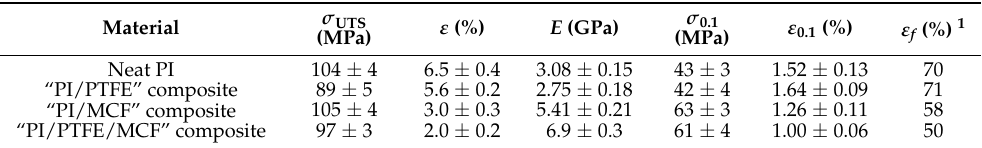
Figure 5. The stress–strain diagrams: 1 (black)—neat PI; 2 (red)—“PI/MCF” composite; 3 (green)— “PI/PTFE” composite; 4 (blue)—“PI/PTFE/MCF” composite. Table 1. The results of the static tensile tests.